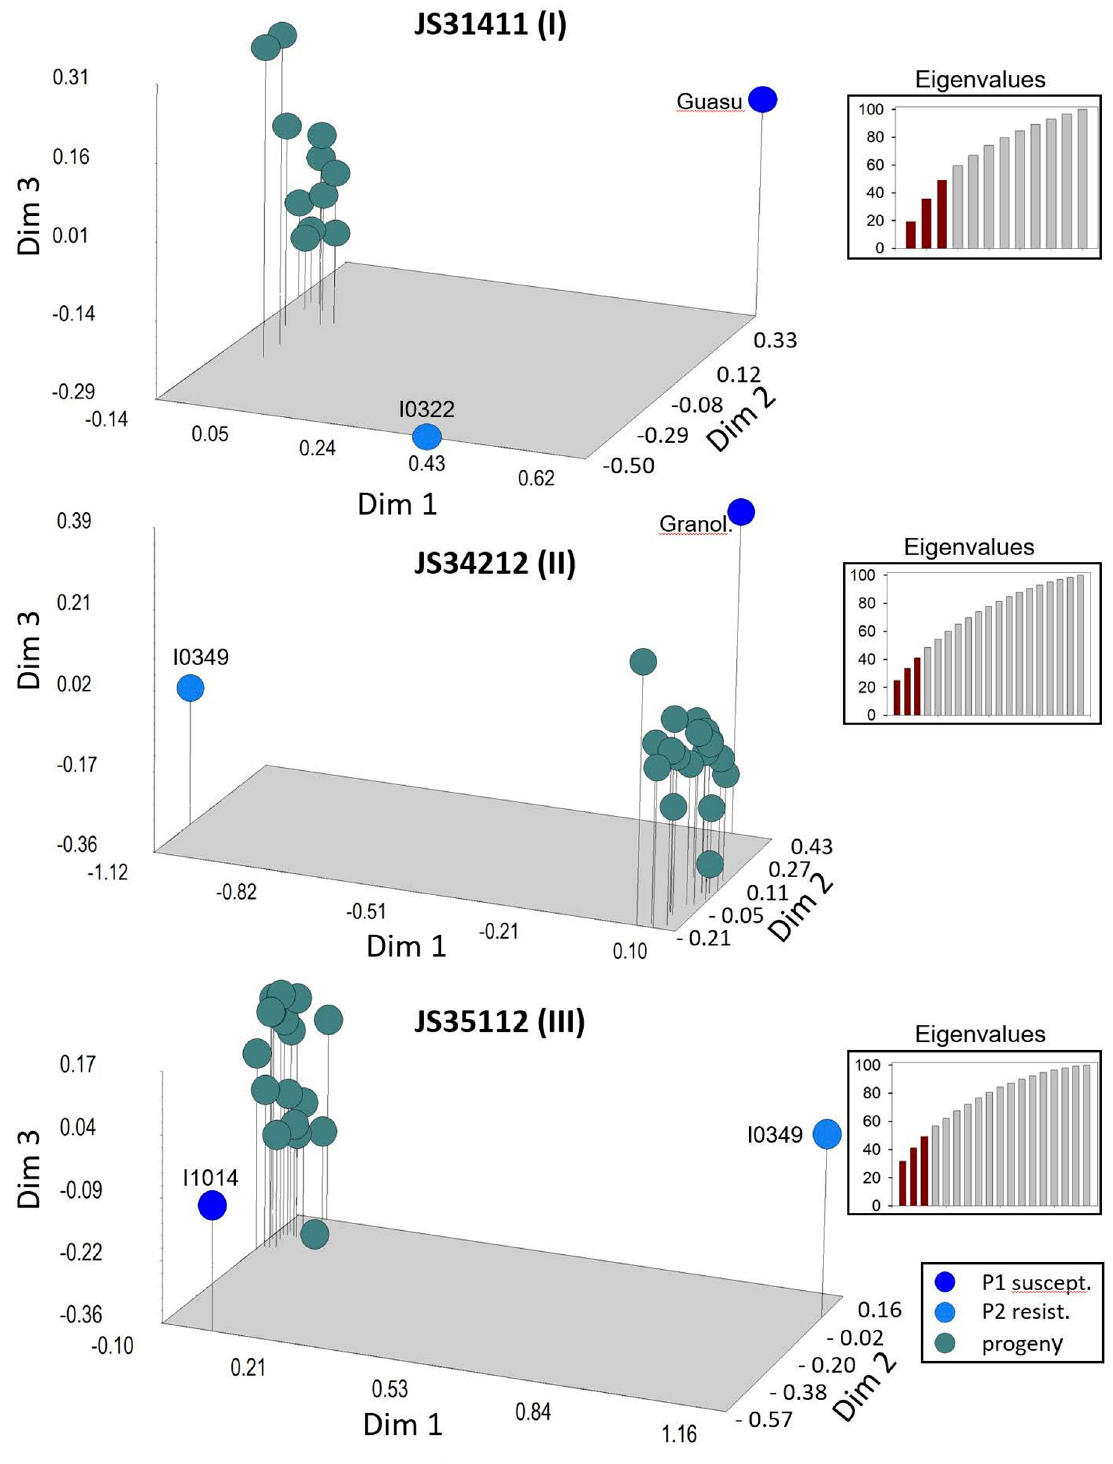
Fig 4. 3D-Principal Coordinate Analysis (3D-PCoA) of genetic distances calculated for parents and progeny of three peanut crosses: JS31411 (I), JS34212 (II) and JS35112 (III) at 52, 45 and 47 loci, respectively. Total number of alleles observed: 180, 217 and 226 for cross JS31411 (I), JS34212 (II) and JS35112 (III),